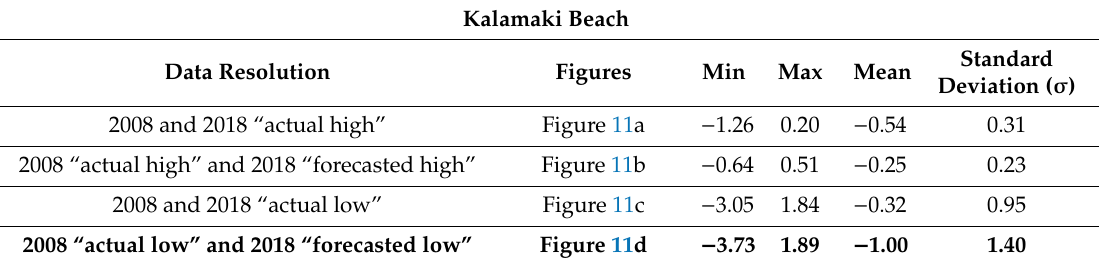
Table 4. EPR statistical rates (in meters / year).